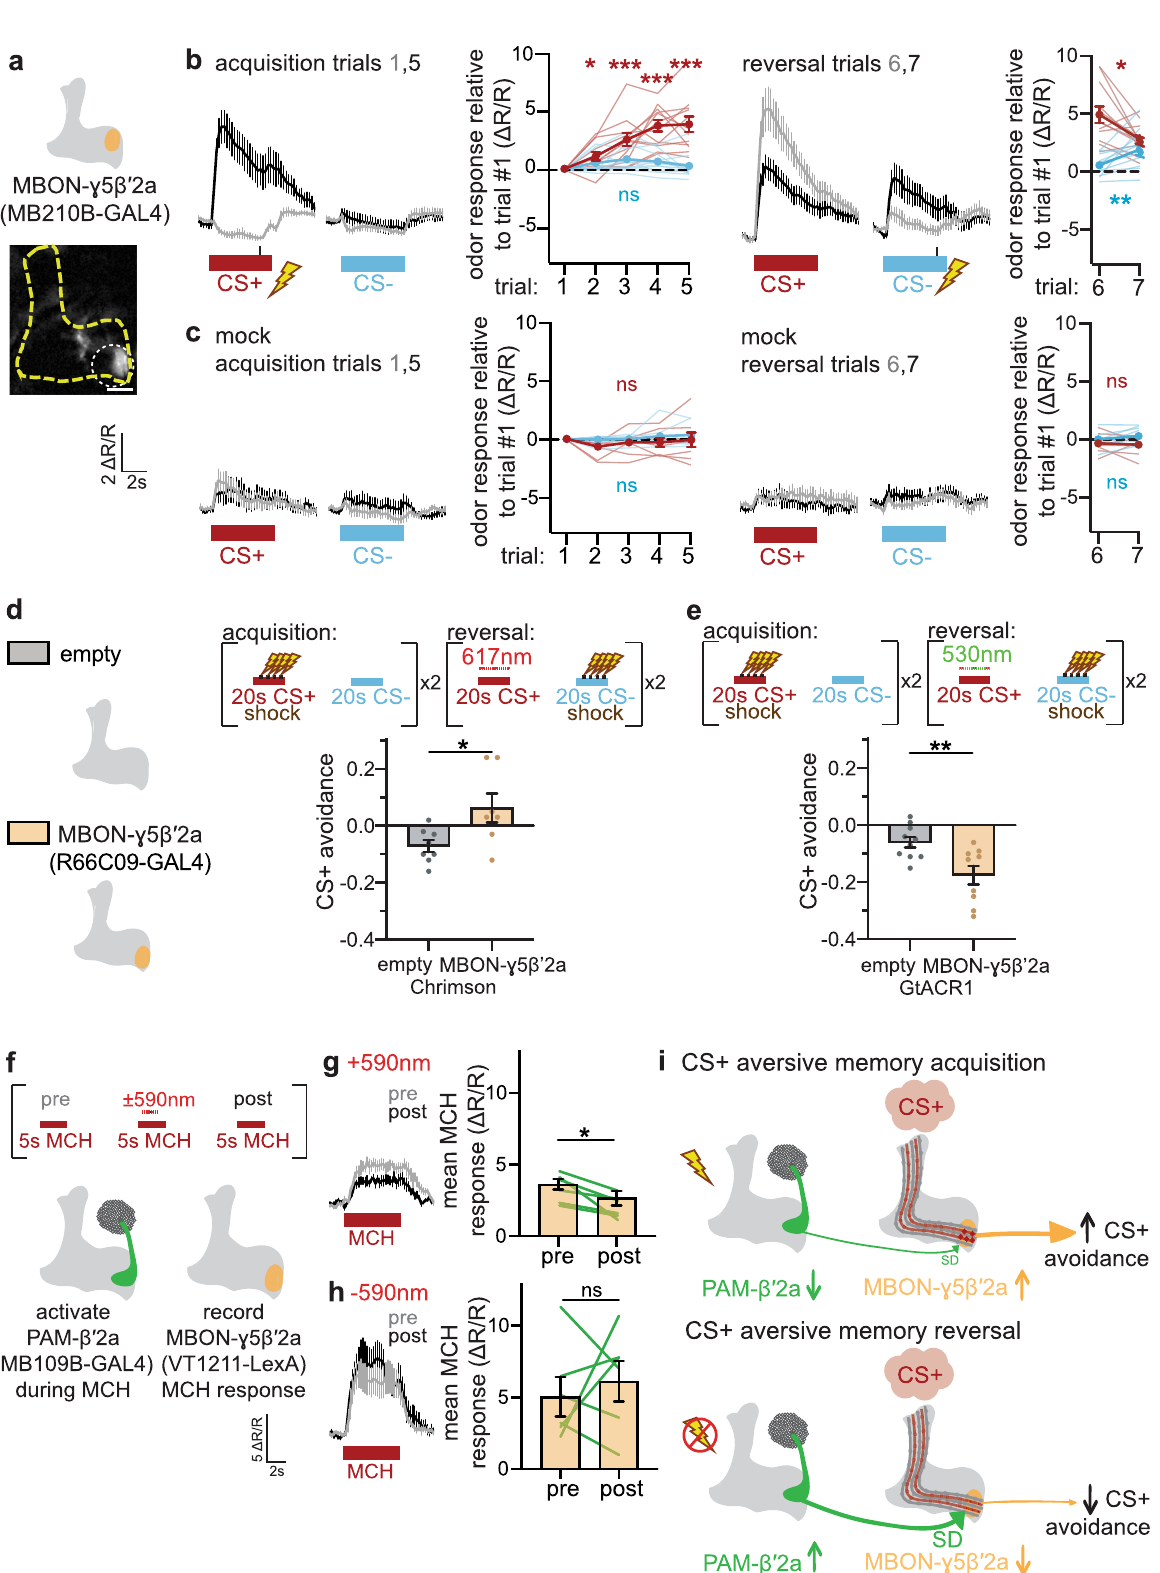
MBON- γ 2 α ′ 1 or MBON- β ′ 2mp with low green light exposure during CS + delivery in reversal trials impairs and enhances CS + reversal, respectively (Fig. 5c). These effects of optogenetic manipulation of MBON- γ 2 α ′ 1 and MBON- β ′ 2mp are again consistent with roles for both of these neurons in encoding shock omission during CS + presentation in reversal trials. These